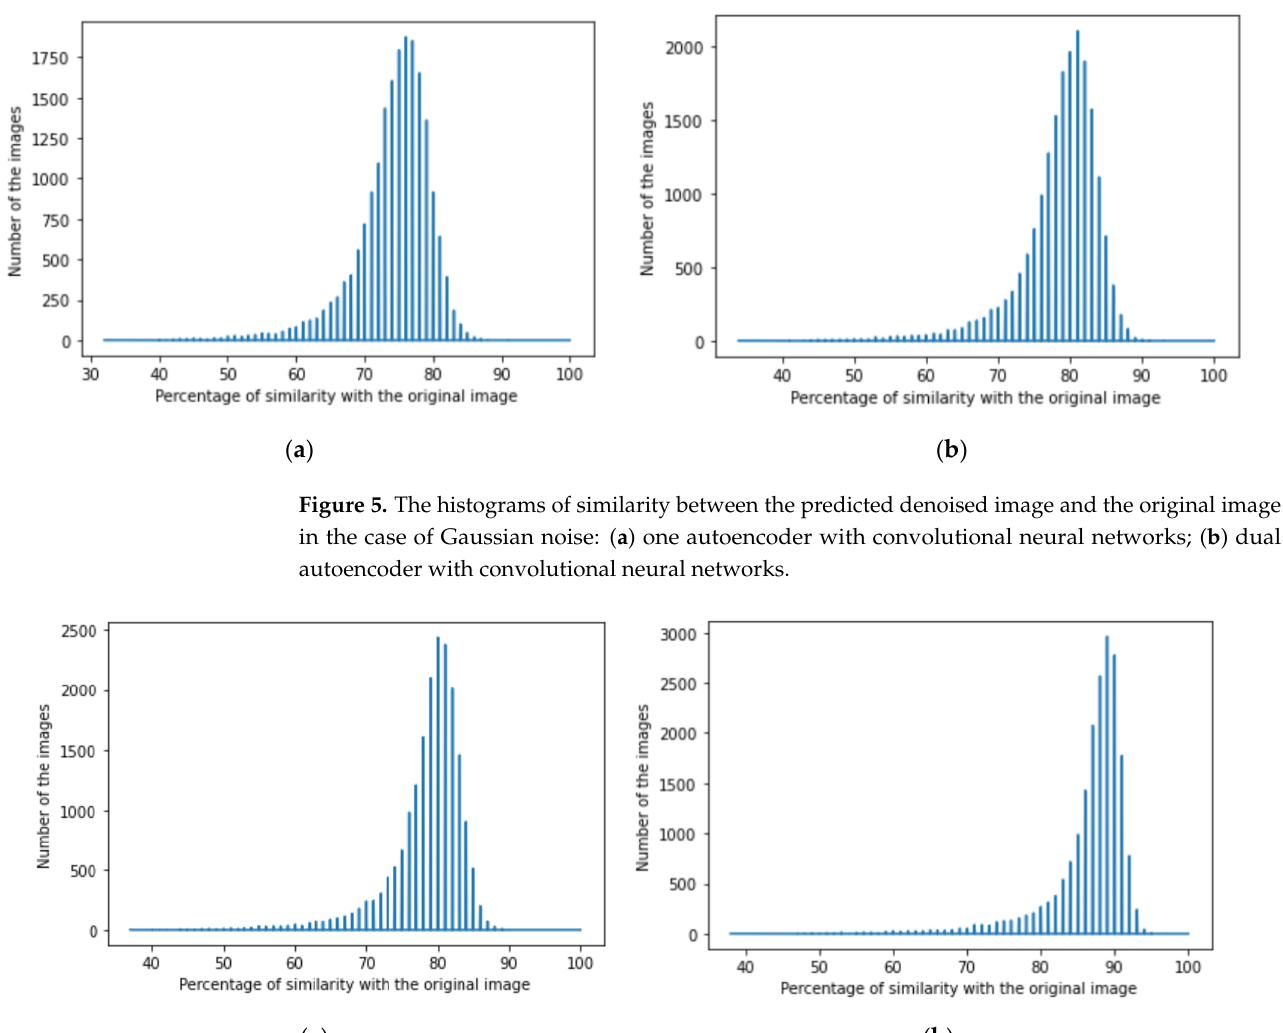
( b ) Figure 7. The histogram of similarity between the predicted denoised image and the original image in the case of Poisson noise: ( a ) one autoencoder with convolutional neural networks; ( b ) dual au- toencoder with convolutional neural networks. ( a ) ( b ) Figure 8. The histogram of similarity between the predicted denoised image and the original image in the case of Poisson noise: ( a ) one autoencoder with separable convolutional neural networks; ( b ) dual autoencoder with separable convolutional neural networks.